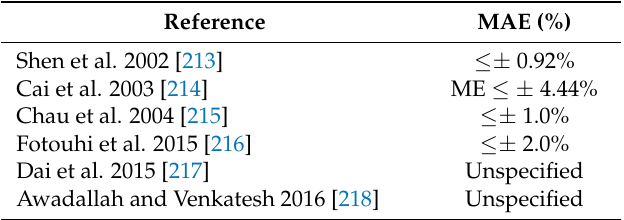
Table 20. MAE/ME of the ANFIS-based SOC estimation